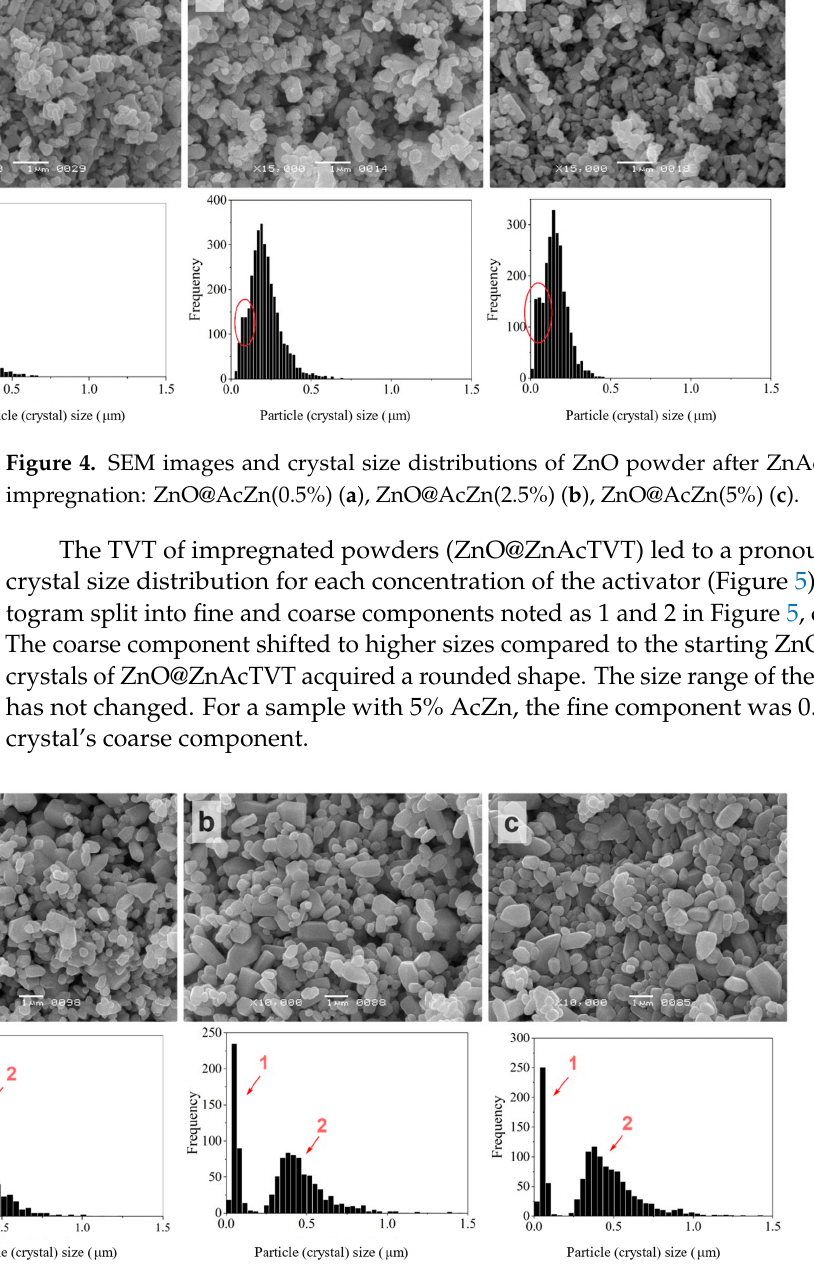
Figure 3. SEM image ( a ) and crystal size distribution ( b ) of the initial ZnO powder. Mean size d mn = 0.193 ± 0.002 μ m, median size d md = 0.174 ± 0.002 μ m.